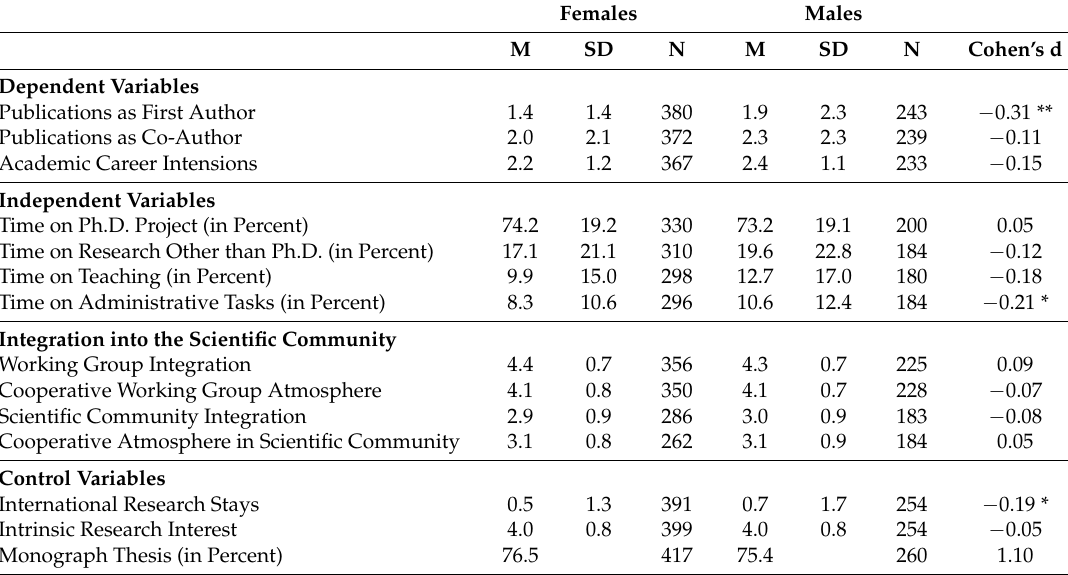
Table 1. Gender Differences in Dependent, Independent and Control